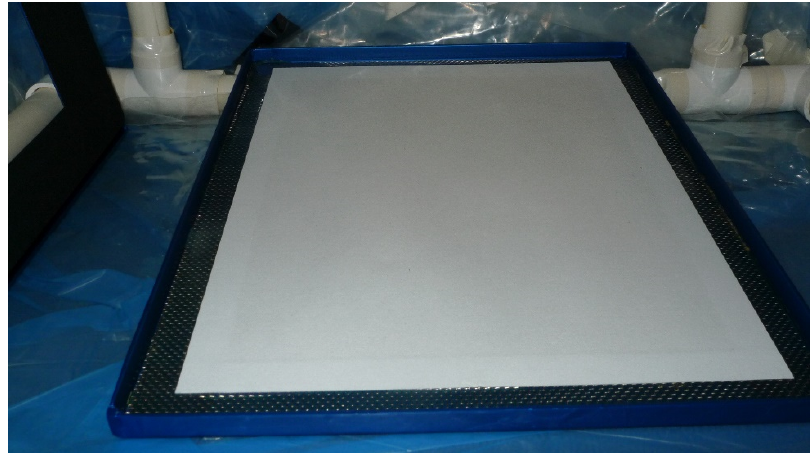
Figure A1. Cassette with filter inside ‘the clean-box’ during routine filter changeover.